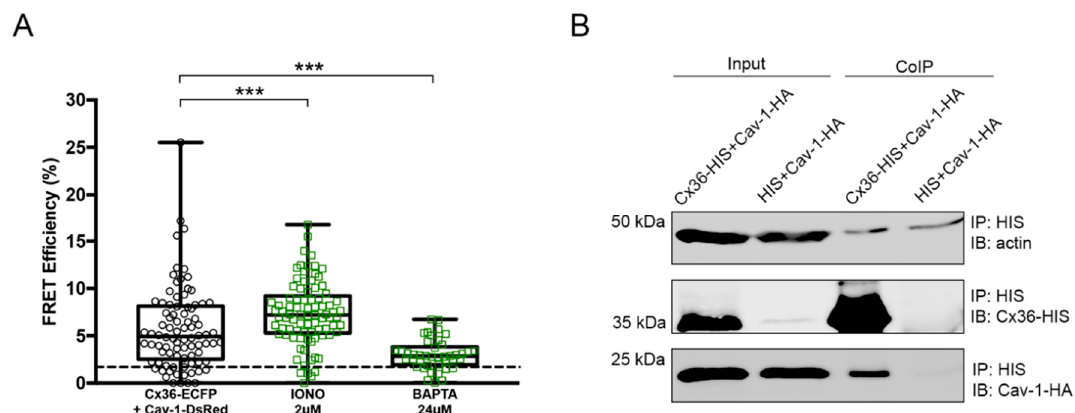
Figure 2. Interaction between Cx36 and Cav-1 is strengthened upon Ionomycin incubation. ( A ) FRET efficiencies of the Cx36-ECFP and Cav-1-DsRed pair under the action of Iono and BAPTA pharmacological agents. The dotted line represents the threshold of 1.7% (equals to 10 nm). Error bars show the minimum and maximum values. Sample sizes were the following: Cx36-ECFP + Cav-1-DsRed: n = 86; Iono: n = 85; BAPTA: n = 42. ( B ) CoIP of Cx36-HIS and Cav-1-HA after stimulation with Iono. HIS antibody was used to pull down the Cx36-HIS and Cav-1-HA complex. Neuro 2a cells double transfected with HIS and Cav-1-HA served as a negative control. Input lanes (cell lysates) show protein levels prior to the assay. CoIP lanes represent eluted protein complexes. Cav-1 eluted together with Cx36, signifying that calcium is required to strengthen the interaction between the two proteins. Anti-HA and anti-HIS antibodies detected Cav-1 and Cx36 proteins, respectively. An anti-ß-actin antibody served as a loading control. IP: immunoprecipitation; IB: immunoblotting. *** p < 0.001.